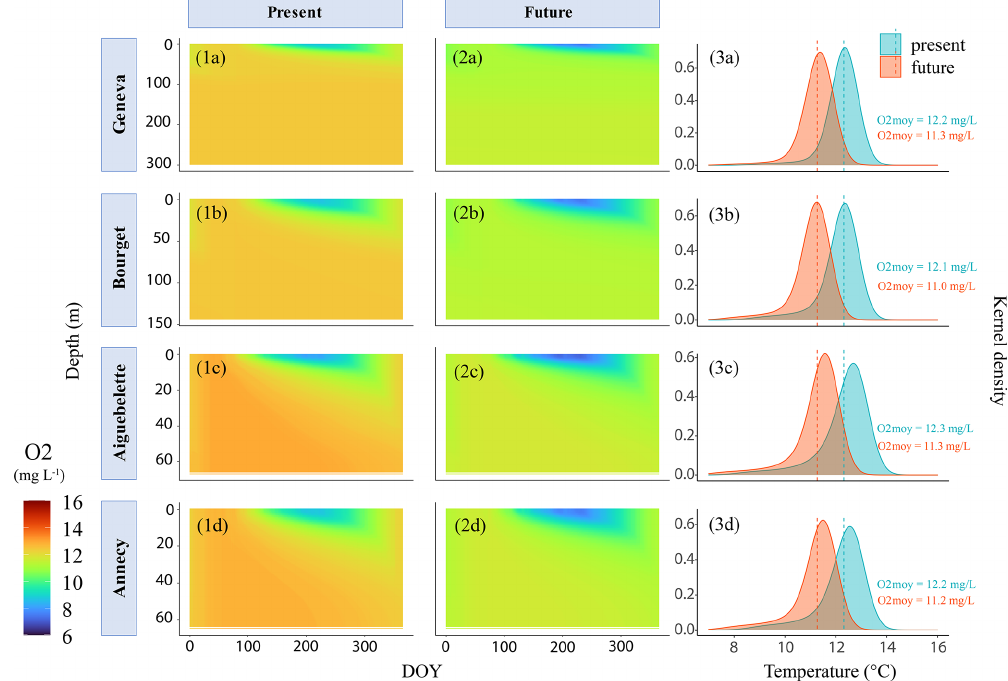
Figure 10. Potential oxygen solubility in lake waters of the four lakes, calculated from MyLake water temperature simulations for the intermediate climate scenario (SSP370). Daily averaged oxygen solubility over the present (1) and future (2) in lakes Geneva (a) , Bourget (b) , Aiguebelette (c) , and Annecy (d) . Estimated frequency of daily average oxygen solubility (3) over the present (2000–2010) and future (2090– 2100) using kernel density. The dashed lines represent the annual average oxygen solubility over the entire